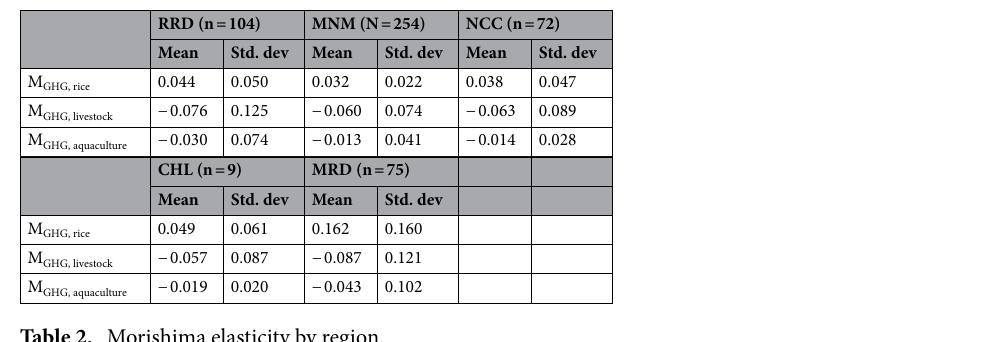
Table 2. Morishima elasticity by